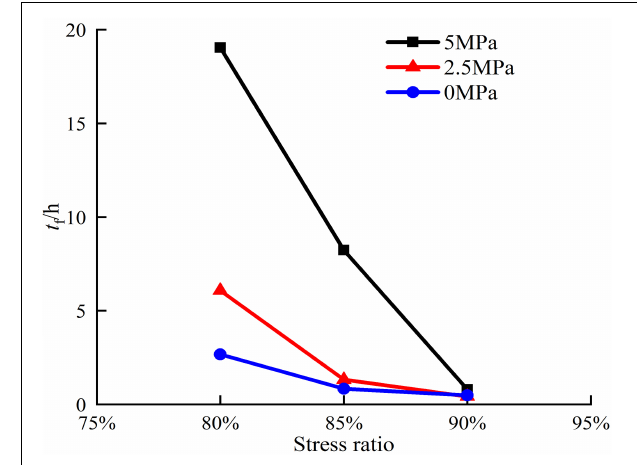
FIGURE 7 | Variation of volumetric strain rates with t / t f . FIGURE 8 | t